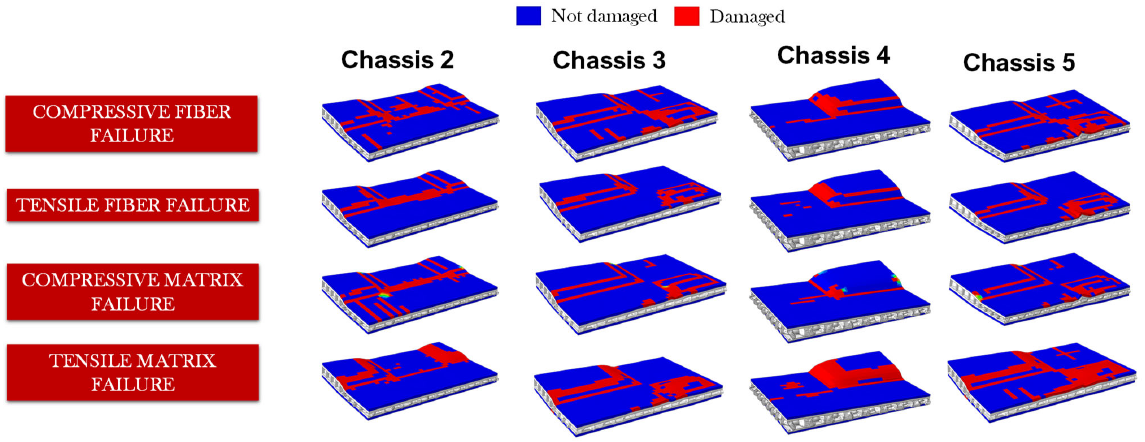
Figure 15. Comparison of intralaminar damages in the upper absorbers skin.